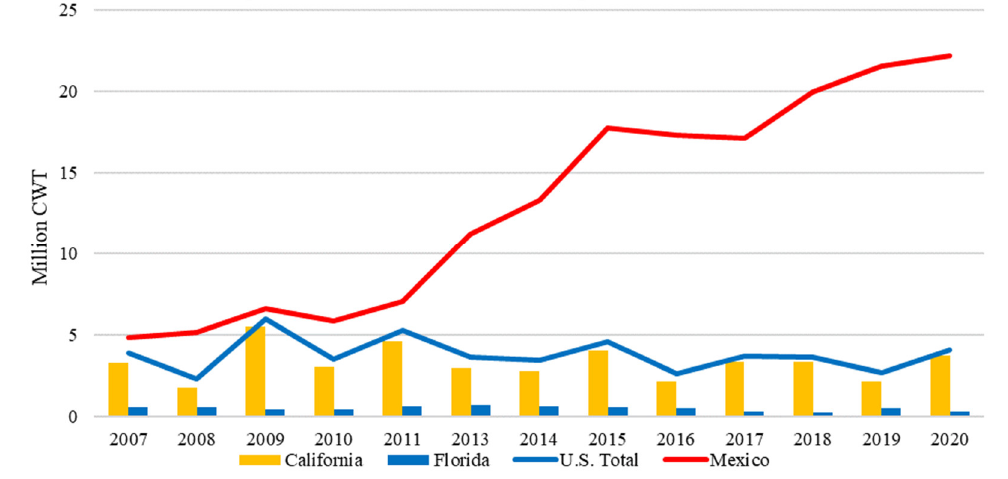
Figure 5. U.S. production and Mexican imports: fresh avocado. Notes: (1) The 2012 state and national production are unavailable. (2) The fresh avocado production of California from 2017 to 2020 and Florida from 2016 to 2020 are undisclosed and calculated based on the percentages of fresh avocados from available data; on average, 99.8% of California and 100% of Florida total production were sold to the fresh market. Sources: USDA FAS [11] ; USDA NASS [37] .